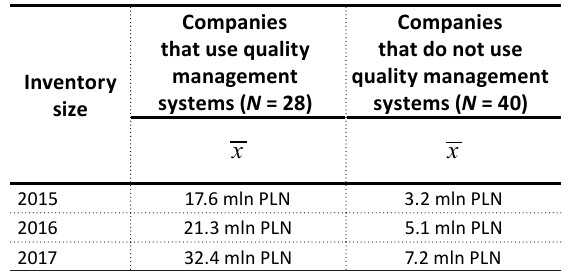
Table 3. Average results of inventory in the analyzed enterprises